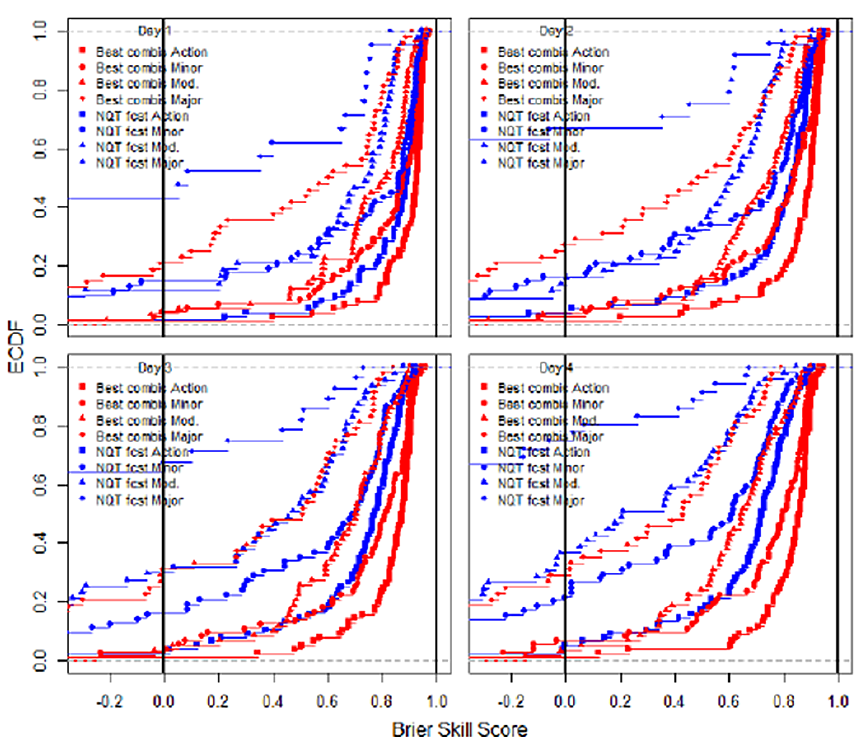
Figure 15. Empirical cumulative density functions of three QR configurations predicting exceedance probabilities of the action, minor, moderate, and major flood stages: the configuration using the transformed forecast as the only independent variable (NQT fcst), and the best-performing combination for each river gauge (upper performance limit; best